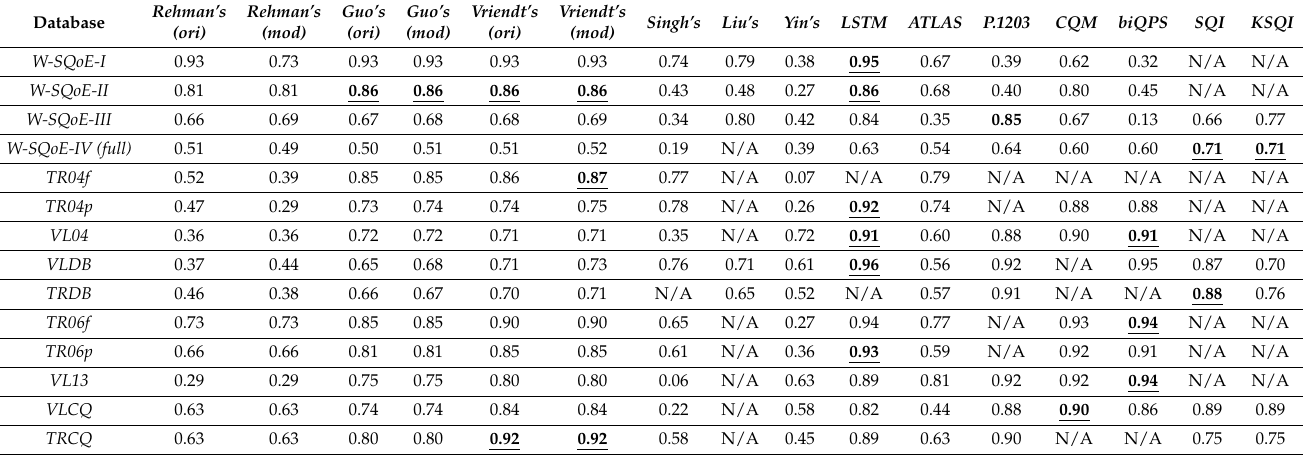
Table 4. Performance in terms of PCC of all models per database. The bold-underlined numbers show the model having the highest